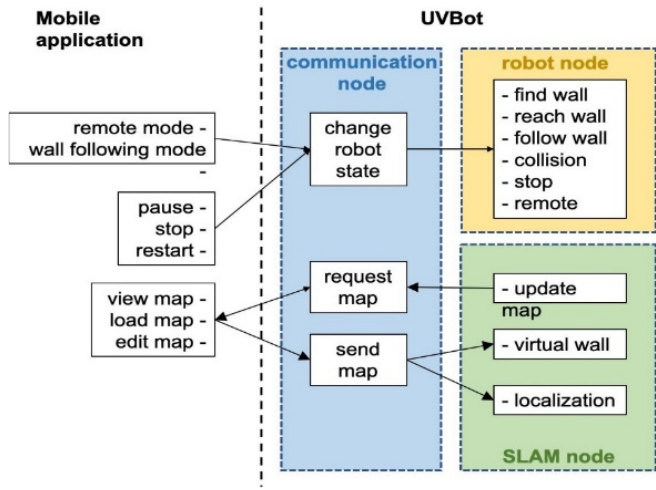
Figure 4. Diagram of the software architecture.